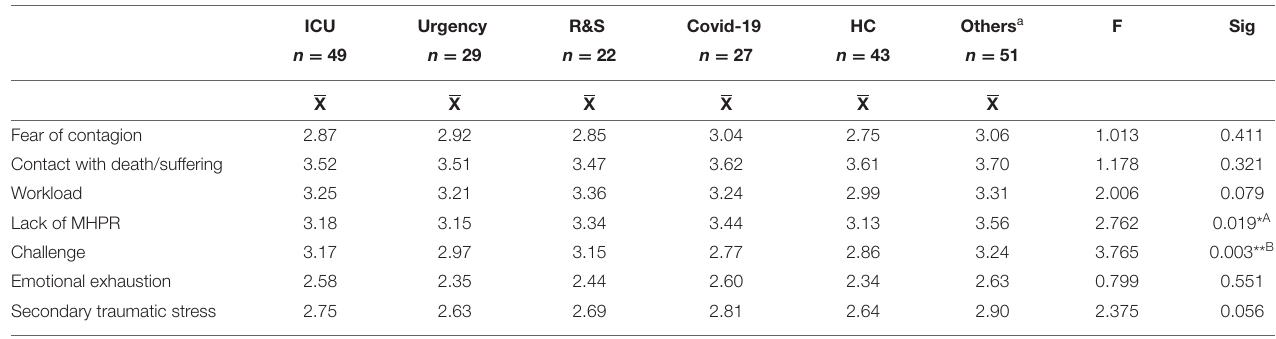
TABLE 4 | Mean differences between interested units. ICU Urgency